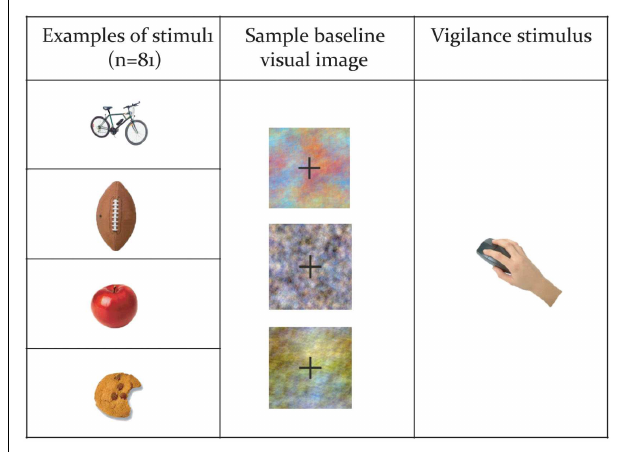
FIGURE 1 | Examples of stimuli from the covert verb generation task.